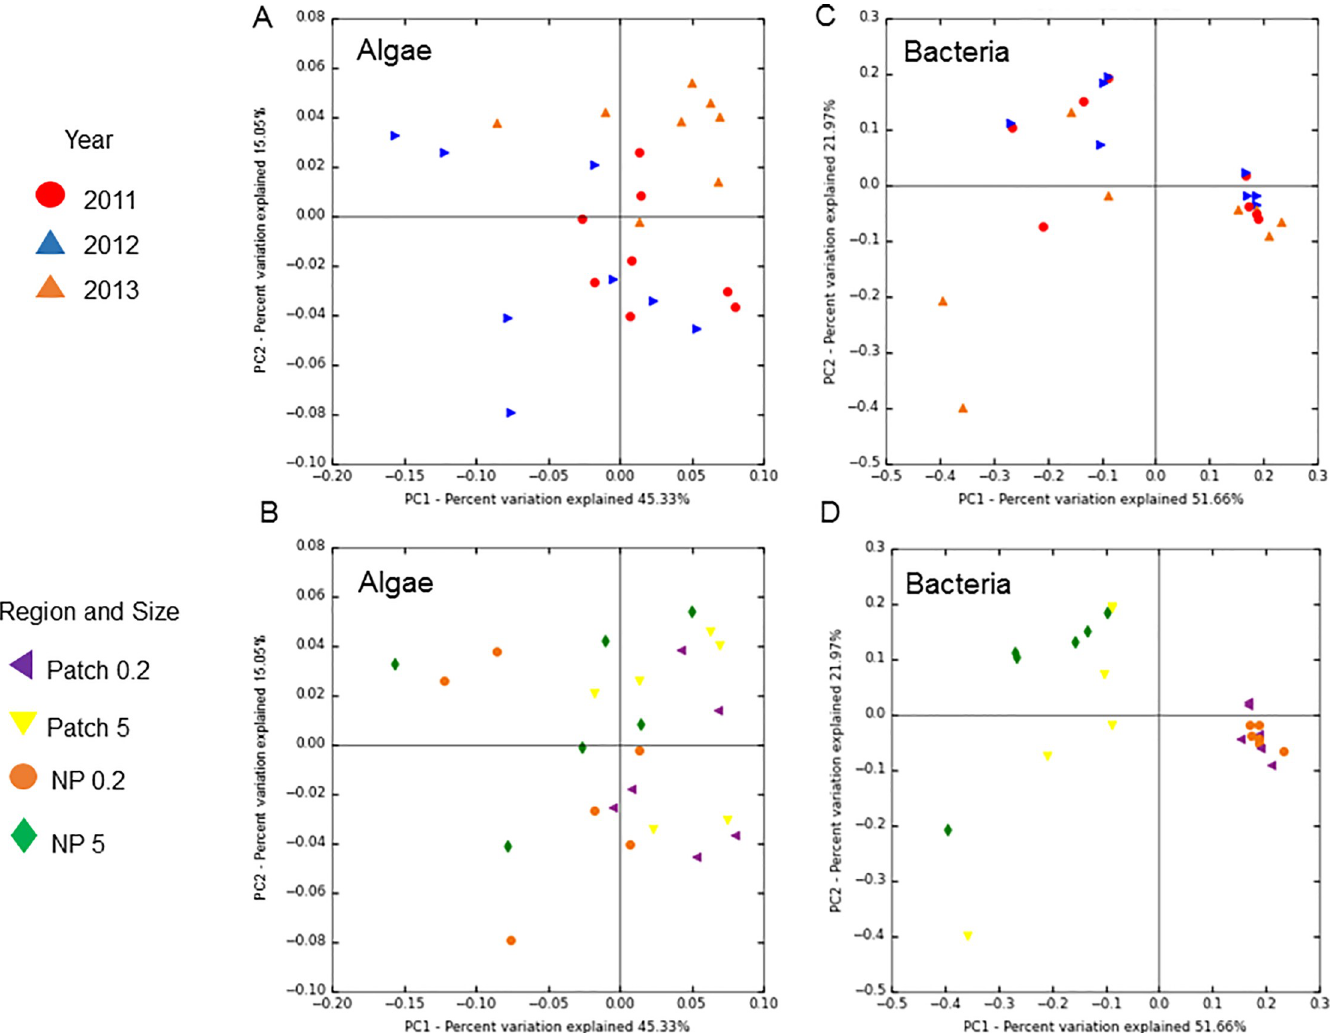
Fig 1. Principal Coordinate Analysis (PCoA) using weighted UniFrac distances of A & B) algal sequences and C & D) bacterial sequences for all field samples by year (2011, 2012 and 2013), and region (patch vs non-patch) and size fraction ( > 0.2 and > 5